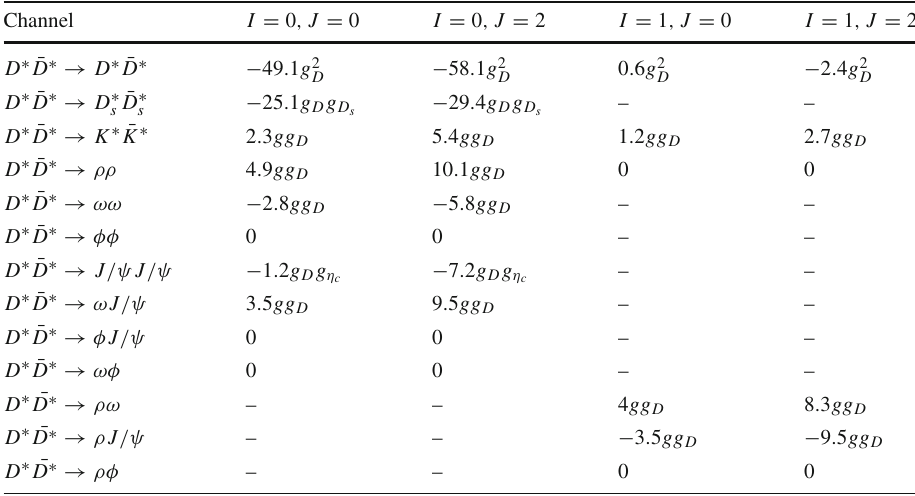
potentials at the threshold of D ∗ ¯ D